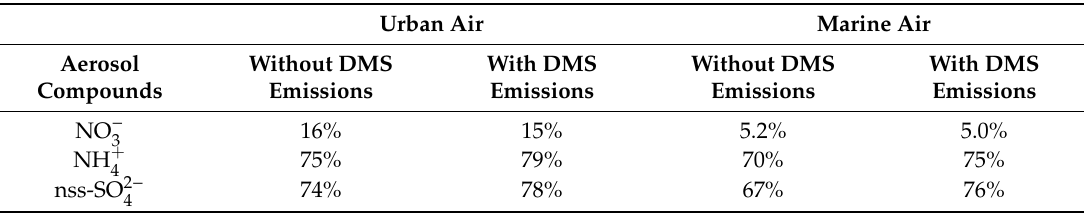
Table 3. Relative amount of fine-mode aerosol in total aerosol (fine- and coarse-mode) mass in urban and marine atmospheres.